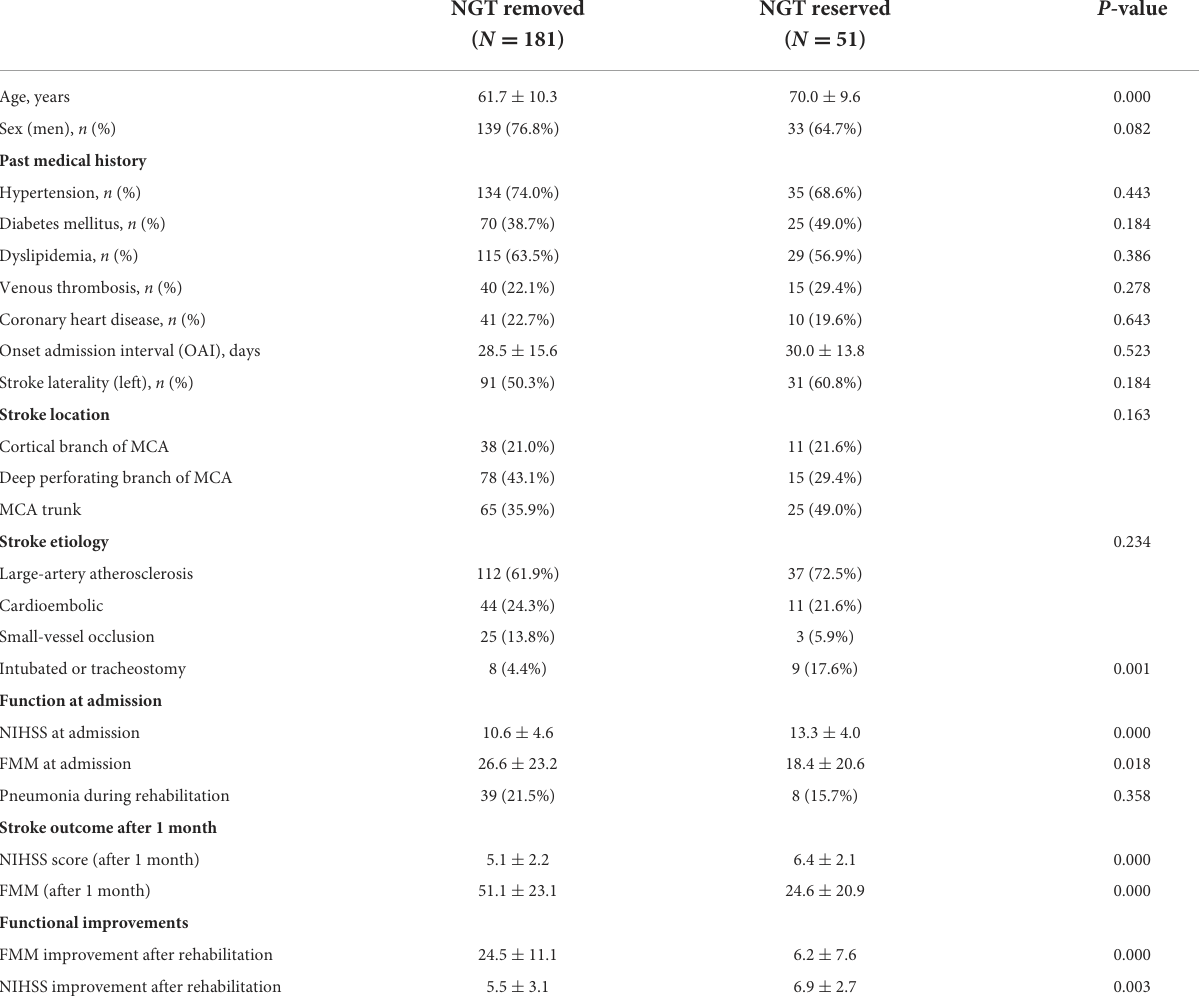
TABLE 2 Risk factors for NGT removal in patients with PSD.